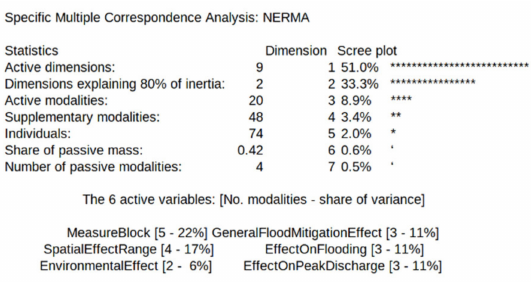
Figure A2. MCA model of rural non-European mountainous area (sub-data set 2).